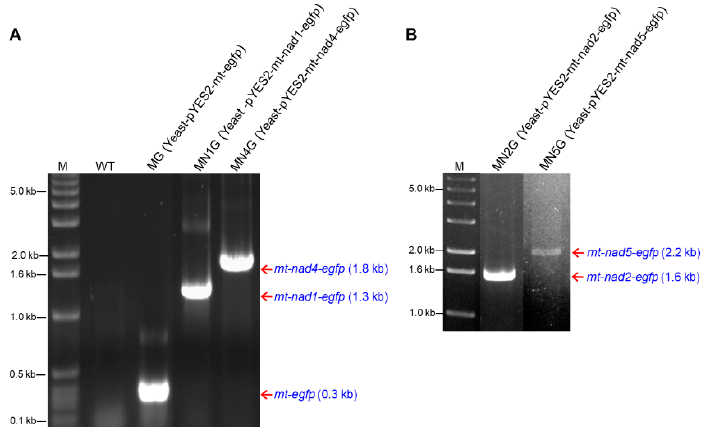
Figure 5. RNA transcription of fusion genes in yeast transformants. Reverse transcription PCR from total RNAs of yeast transformants that were amplified by using a pair of primers, mt-egfpF and mt- egfpR. ( A ) The 0.3 kb mt-egfp fragment, the 1.3 kb mt-nad1-egf fragment, and the 1.6 kb mt-nad2-egfp fragment. ( B ) The 1.8 kb mt-nad4-egfp fragment and the 2.2 kb mt-nad5-egfp fragment were